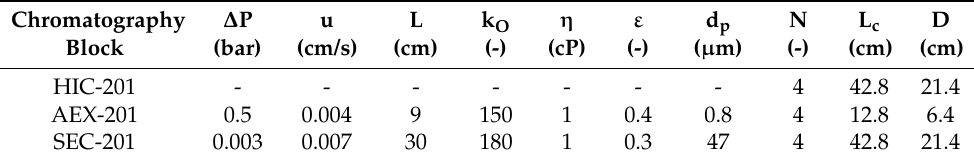
Table 5. Design specifications for chromatographic columns.